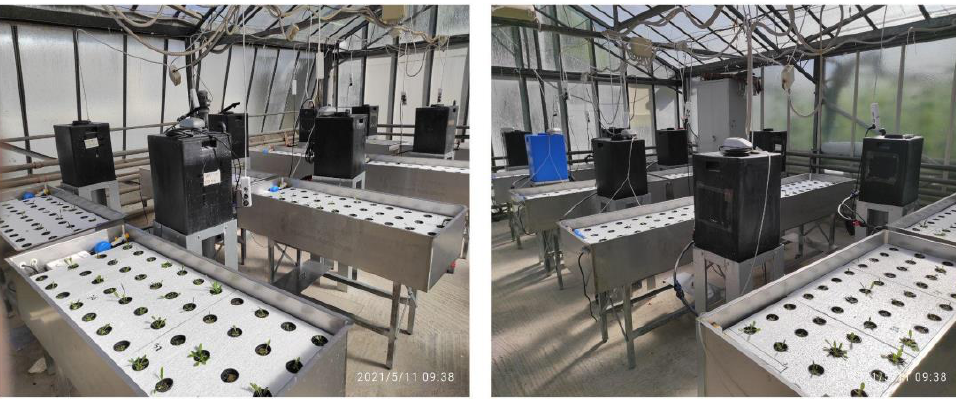
Figure 1. View of the chamber where the experiment took place, with the 16 tanks and floating rafts, after transplanting took place.